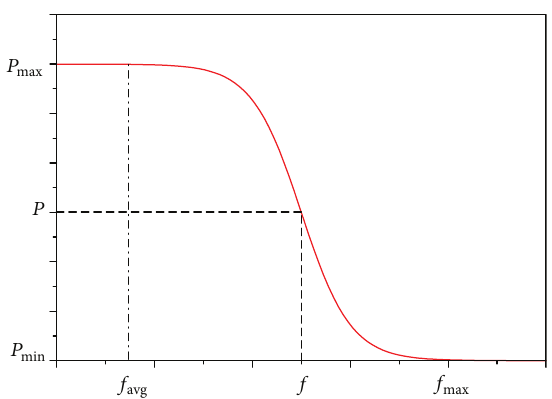
Figure 3: The adaptive adjusting curve of 𝑃 𝑐 and 𝑃 𝑚